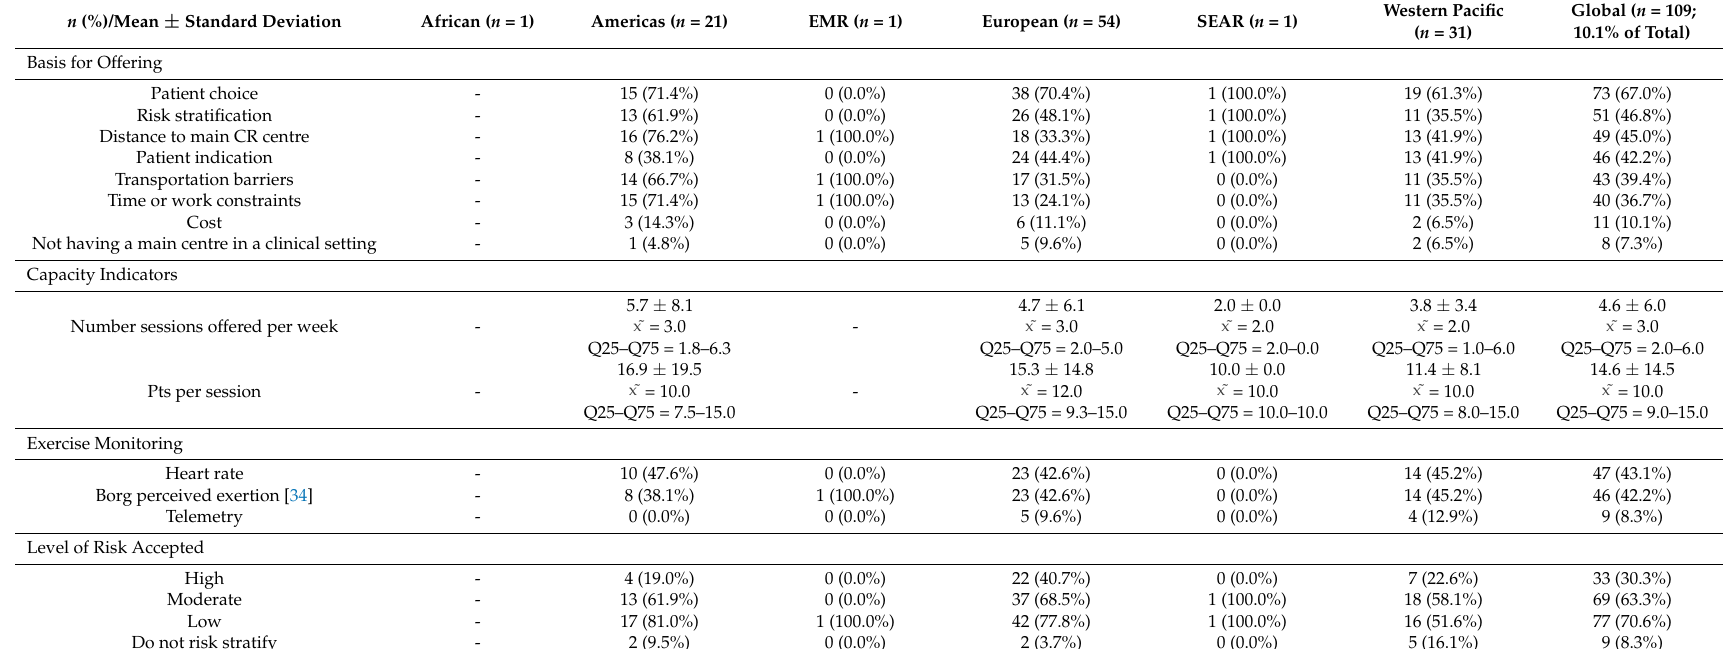
Table 1. Characteristics of Home-Based Programs by World Health Organization Region.